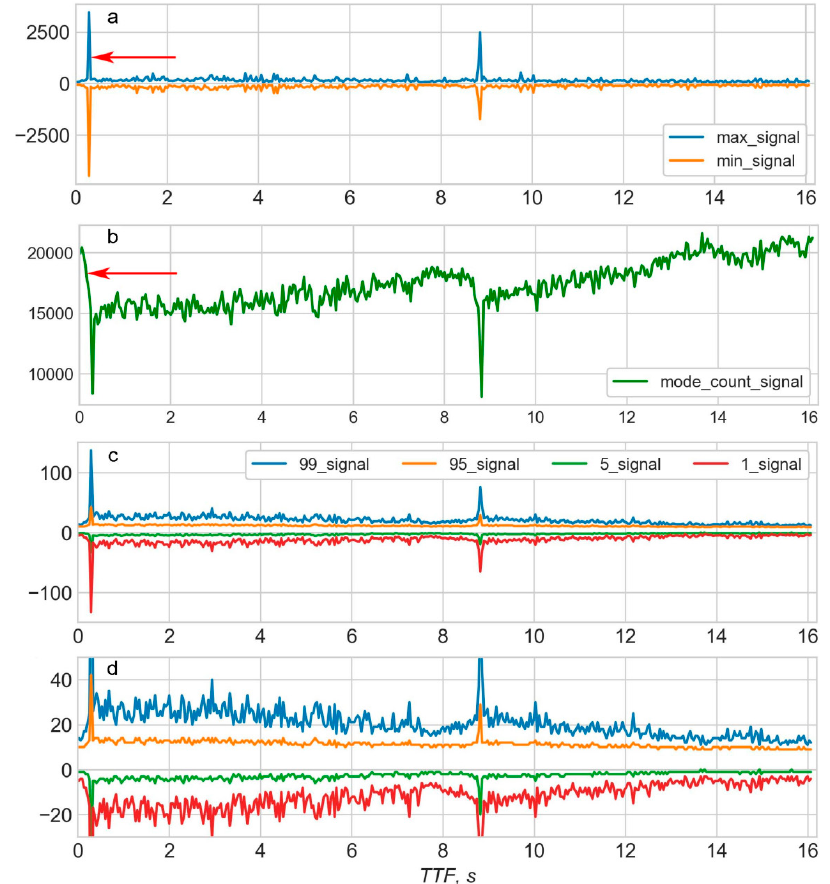
Figure 2. Some of the features plotted against time to failure (TTF) for the 8th “earthquake” cycle: ( a )—maximums and minimums; ( b )—number of mode appearance; ( c , d )—99th, 95th, 5th, and 1st percentiles.